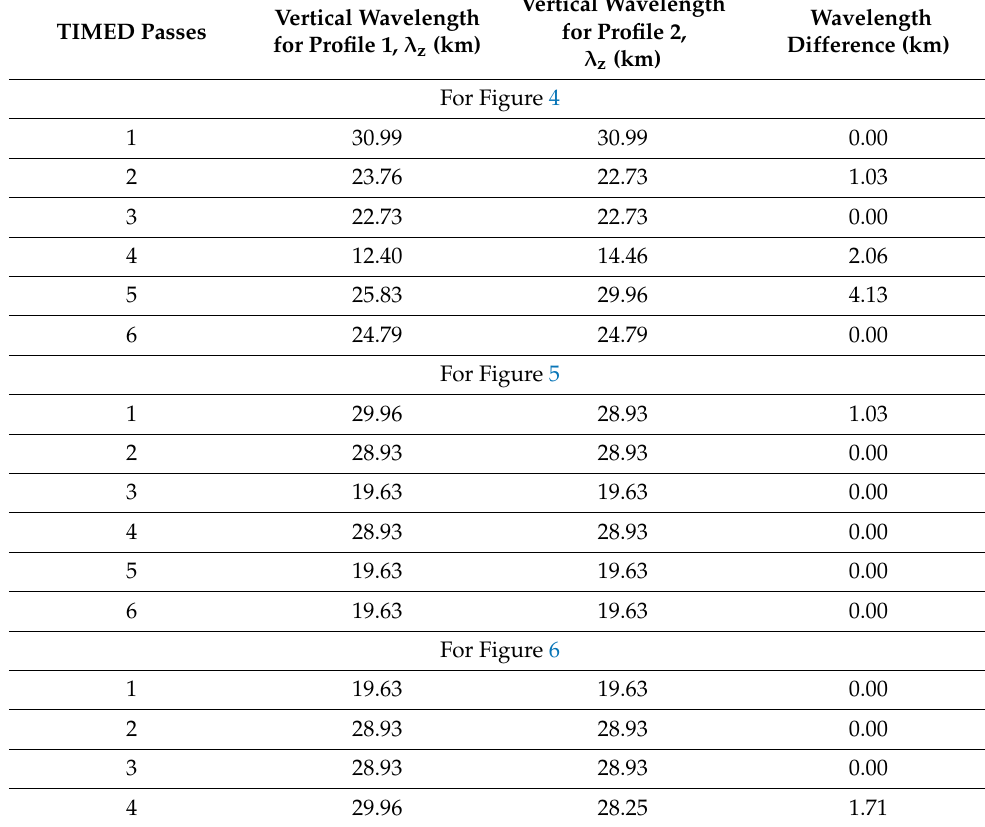
Table 2. Vertical wavelengths of gravity waves corresponding to dominant wavelet powers shown in Figures